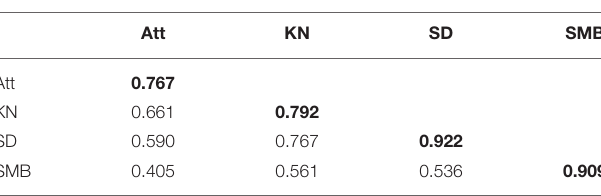
TABLE 5 | Fornell and Larcker criteria.